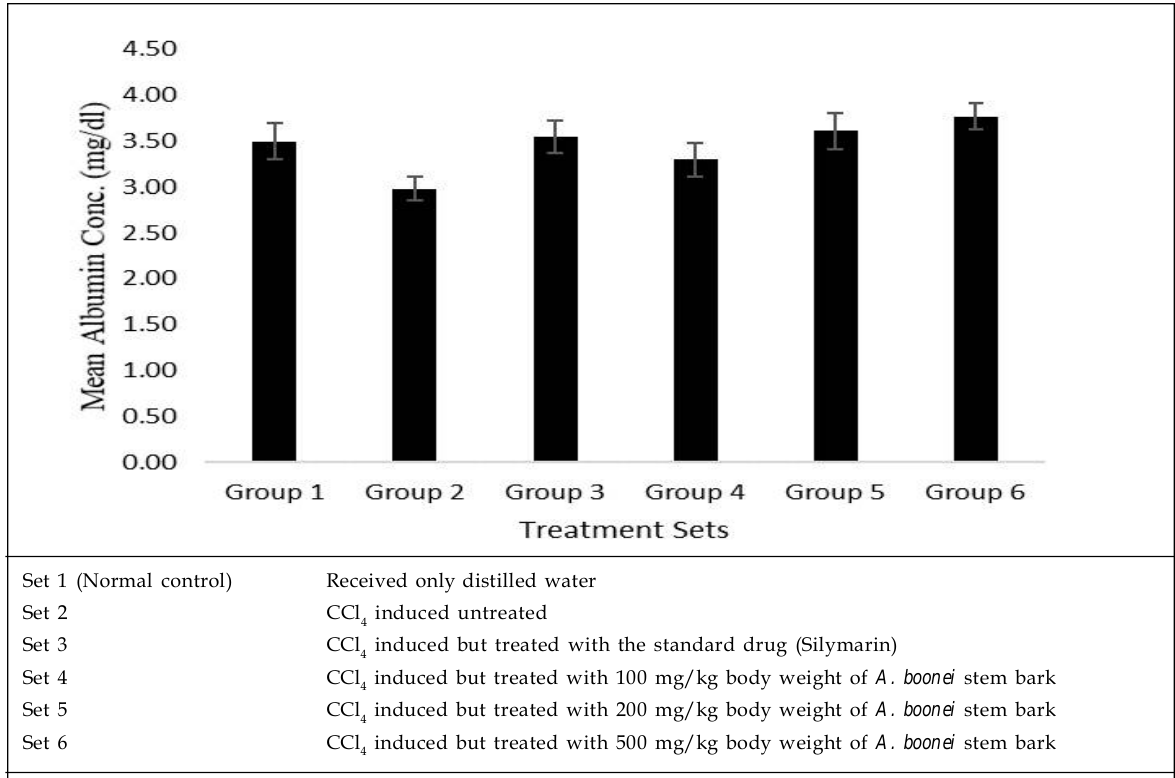
Figure 2: Albumin (ALB) concentration of male Wistar albino rats administered A. boonei stem bark extract